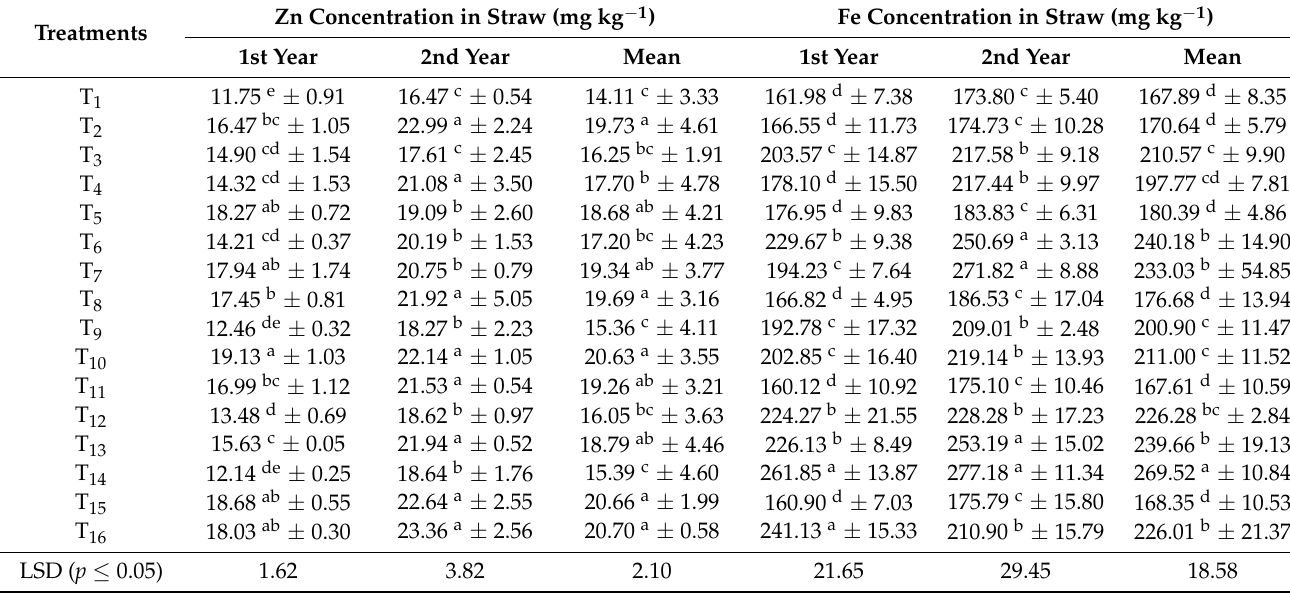
Treatments are detailed in Table 1. In columns, means with a similar or dissimilar letter(s) were evaluated with the least significant difference (LSD) multiple range tests, using a probability level of p ≤ 0.05, along with standard